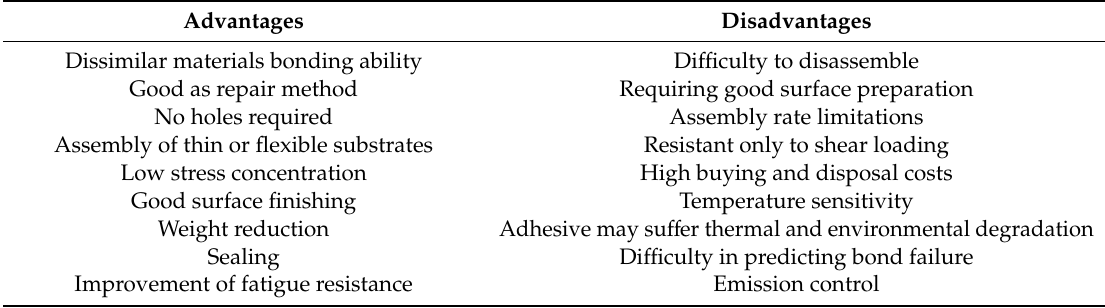
Table 2. Advantages and disadvantages of adhesive